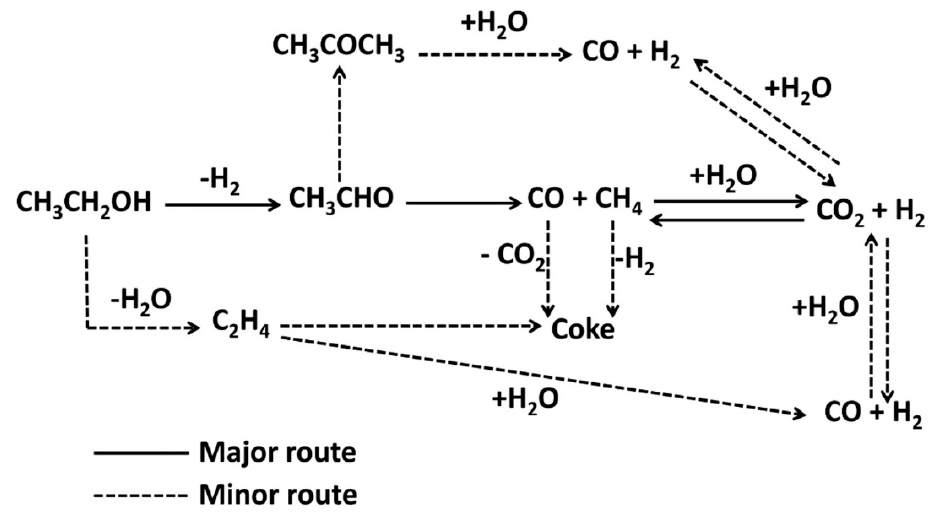
Figure 7. Reaction network proposed for ESR. Reprinted with permission from Ref. [17]. Copyright 2022 Elsevier.